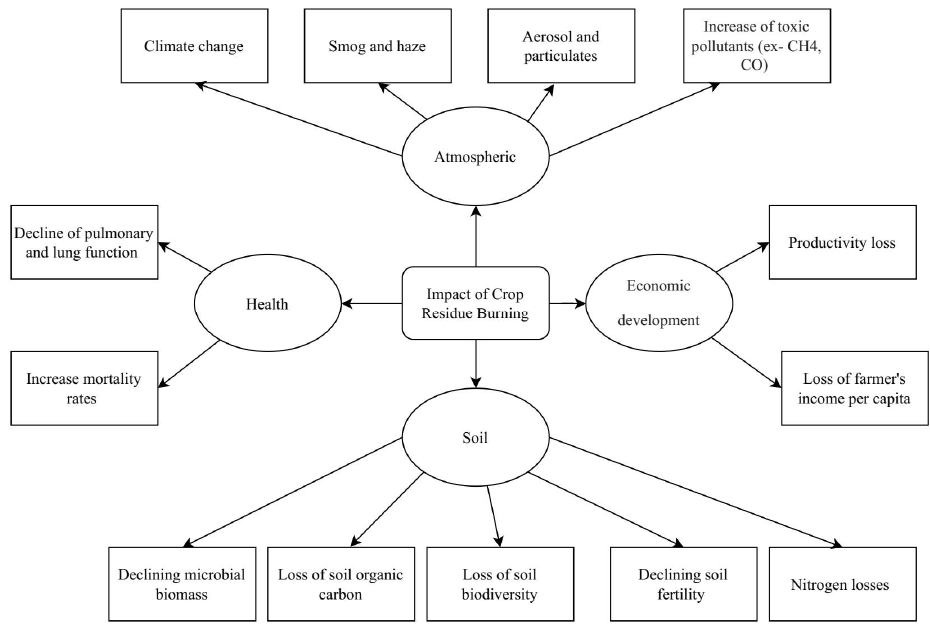
Figure 1. Impacts of crop residue